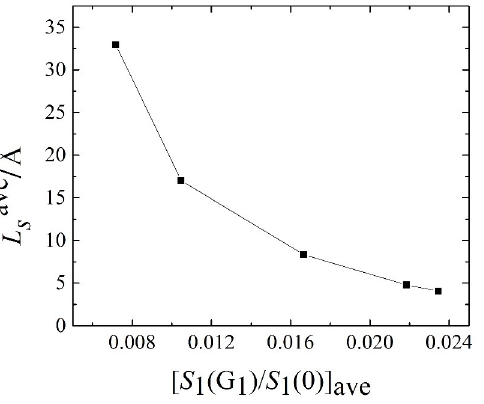
Fig 7. The behaviour of the average slip length, least squares, as a function of the normalised main peak of the in- plane structure coefficient, S (G 1 )/ S (0).